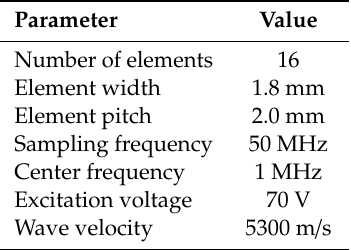
Figure 2. Experimental apparatus. Table 1. Experimental array parameters.